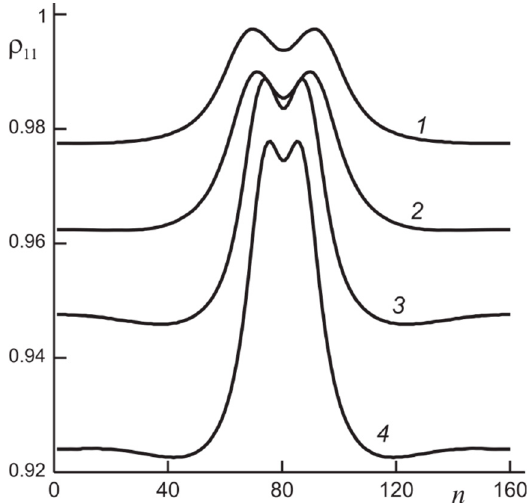
Figure 6. Profiles of the ground state population for stationary solitons for the Rabi frequency Ω = 0.45 (1), 0.48 (2), 0.78 (3), and 0.95 (4).